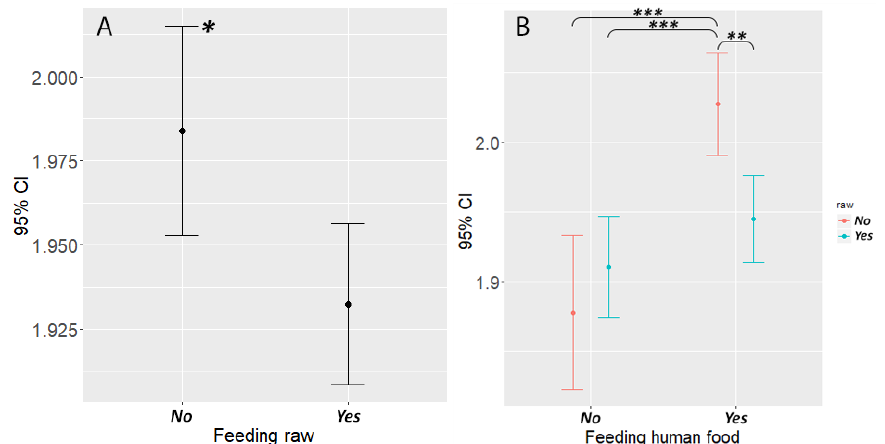
Figure 4. The association between feeding uncooked or raw food and the body condition of the dog.